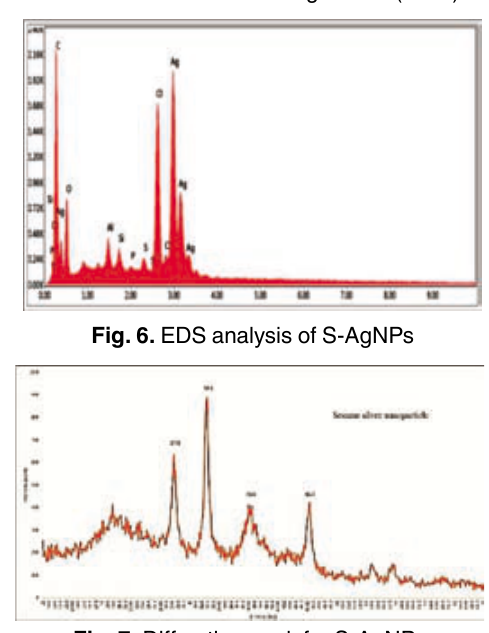
Fig. 7. Diffraction peak for